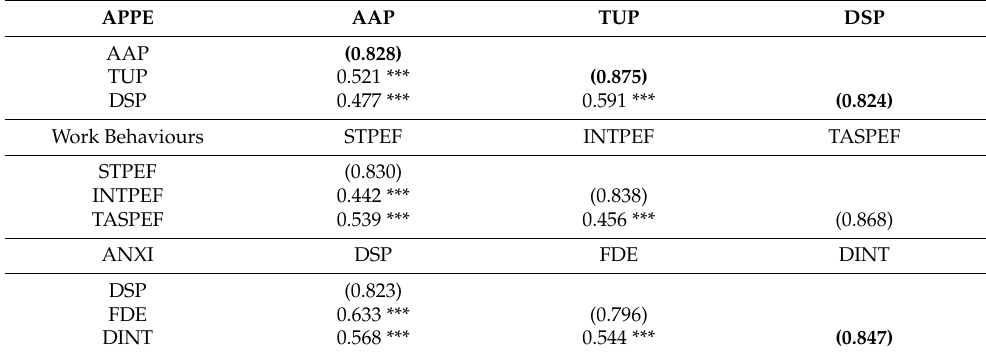
Table 4. Results of discriminant validity.